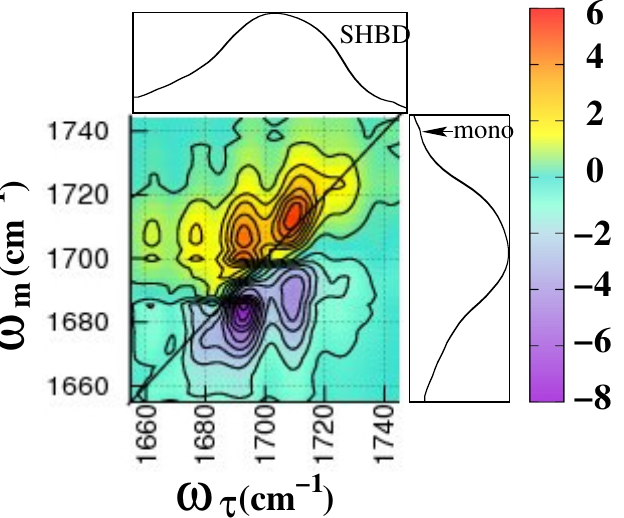
Figure 7. 2DIR spectra of 2-Pyrrolidinone in CCl 4 at a population time of T ω = 200fs. Two- dimensional spectra are embedded with 1DIR spectra from the top and right side. The red contours in 2DIR spectra are positive-trending and the blue are negative-trending. The excitation frequency is plotted in the horizontal axis and the detection frequency is plotted in the vertical